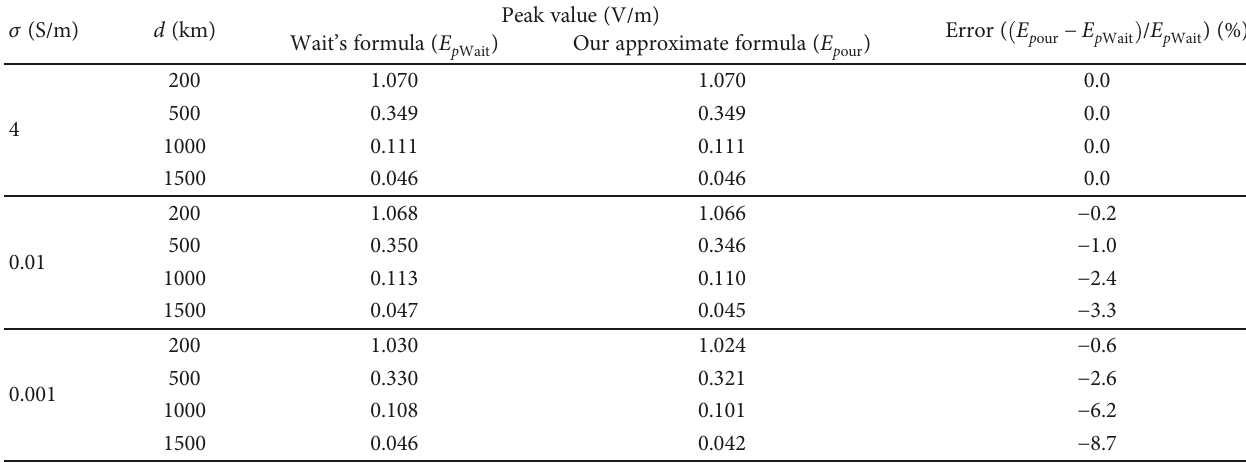
ff erent earth conductivity ( σ ) varying from Table 1: Relative errors of the peak value ( E p ) calculated by our approximate method for di 0.001S/m to 4 S/m. The propagation distances ( d ) between lightning and observation point ranges from 200km to 1500km. σ (S/m)